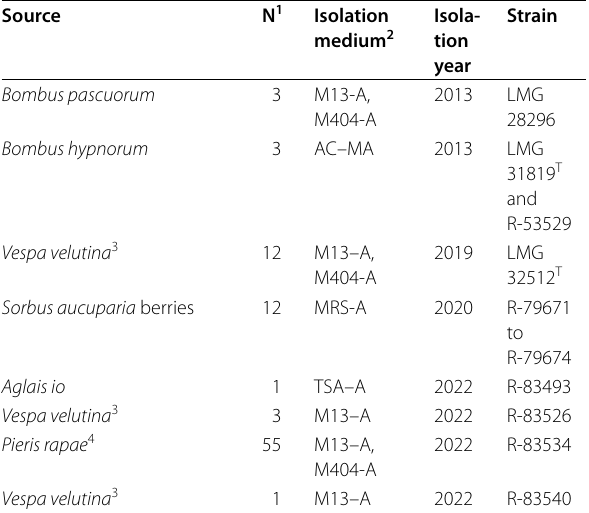
Table 1 Overview of new Commensalibacter isolates, their isolation source and other isolation details. All isolates originated from Belgium. Insect samples were whole gut samples Source N